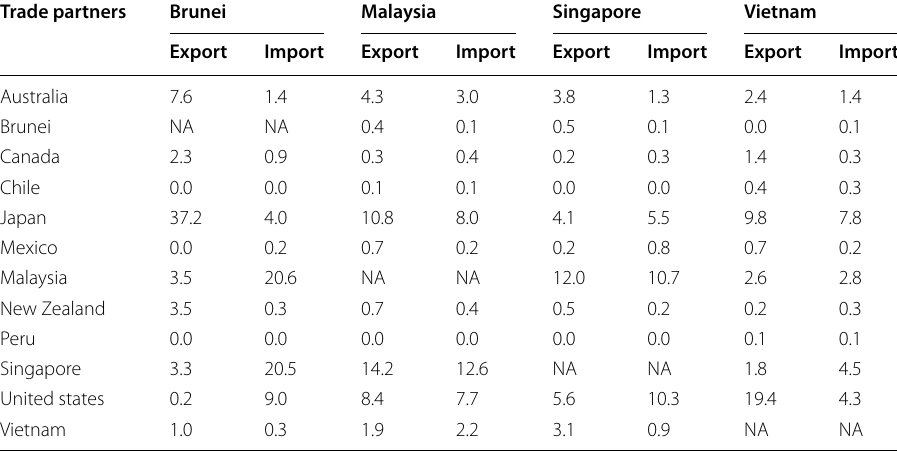
Table 3 Share (in %) of trade partners in TPP in export and import of each of the TPP- ASEAN economies in 2014. Source : ASEAN Secretariat, ASEAN Statistics available at